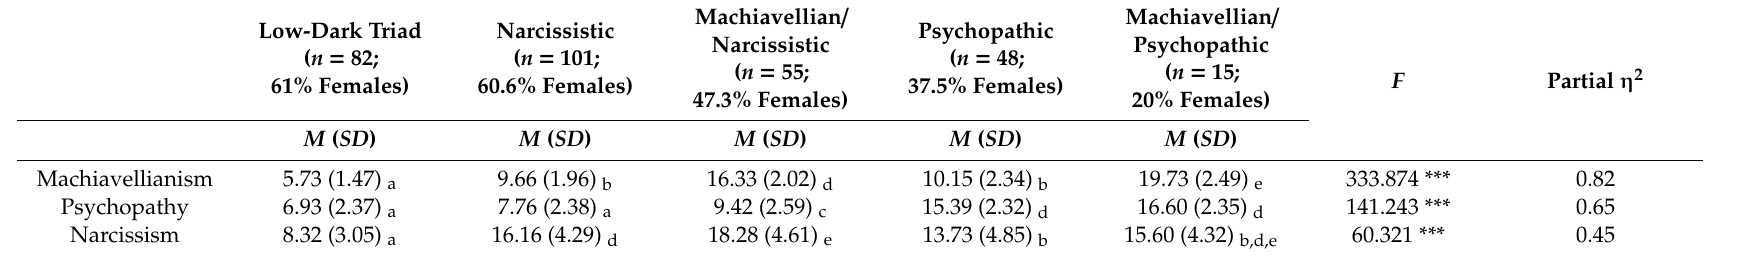
Table 3. Descriptive statistics and di ff erences among subgroups in Dark Triad traits class